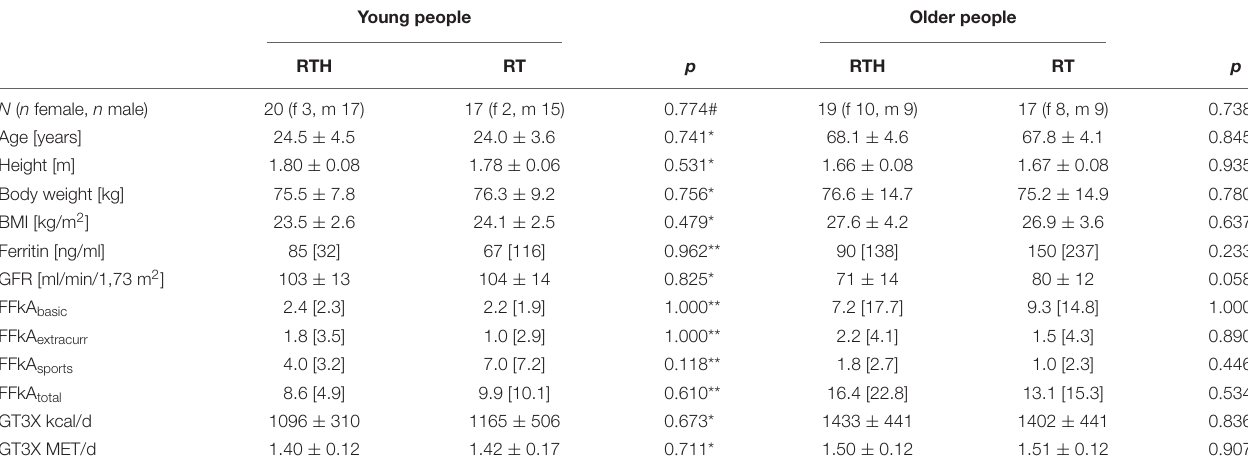
TABLE 1 | Base line data of the participants (data are shown as mean ± standard deviation or median [interquartile range]). Young people Older